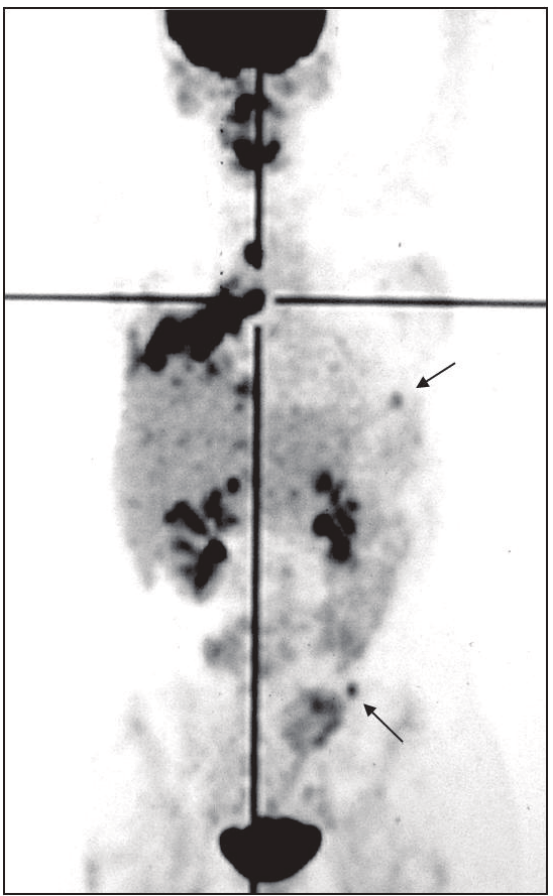
Figure 2: . Top: Bronchial biopsy showing PPA. A: Diffuse submuco- sal infiltration by anaplastic, large cells (hematoxylin-eosin, original x 25); B: Neoplastic cells stained positively for CD31 (original x 25). Bottom: Lung biopsy showing PEH; C: nodule with a fibrotic core and a micropolypoid structure at their perifery (hematoxylin-eosin, original x 250); D: Rare CD34 positive cells (original x 400).